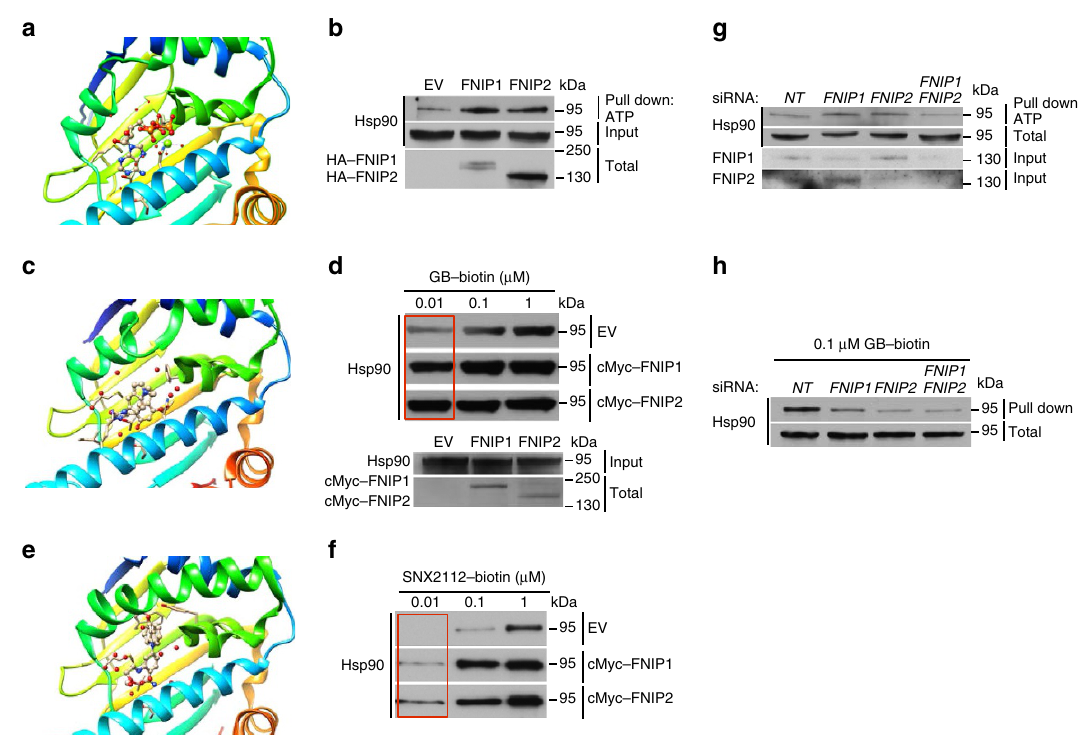
Figure 7 | Overexpression of FNIPs enhance Hsp90 binding to drugs. ( a ) Structure of human Hsp90 a N-domain bound to ATP (PDB: 3T0Z). ( b ) HA–FNIP1, HA–FNIP2 or empty vector (EV) were transiently overexpressed in HEK293 cells. Lysates were incubated with ATP agarose. Hsp90 binding to ATP agarose was examined by immunoblotting. ( c ) Structure of human Hsp90 a N-domain bound to GB (PDB: 3TUH). ( d ) cMyc–FNIP1, cMyc–FNIP2 or empty vector (EV) were transiently overexpressed in HEK293 cells. Lysates were incubated with indicated amounts of biotinylated GB followed by streptavidin agarose beads. Hsp90 was detected by immunoblotting. ( e ) Structure of human Hsp90 a bound to related SNX2112 compound, tetrahydro-4H- carbazol-4-one (PDB: 3D0B). ( f ) Lysates from d were incubated with indicated amounts of biotinylated SNX2112 followed by streptavidin agarose beads. Hsp90 was detected by immunoblotting. ( g ) FNIP1 and FNIP2 were silenced by siRNA in HEK293 cells. Lysates were incubated with ATP agarose. Hsp90 binding to ATP agarose was examined by immunoblotting. NT represents non-targeting siRNA control pools. ( h ) Lysates from g were incubated with indicated amounts of biotinylated GB followed by streptavidin agarose beads. Hsp90 was detected by